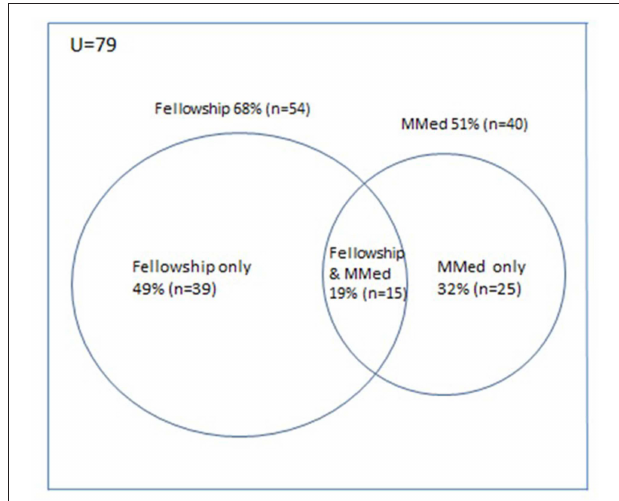
FIGURE 4 | Specialist qualifications obtained.